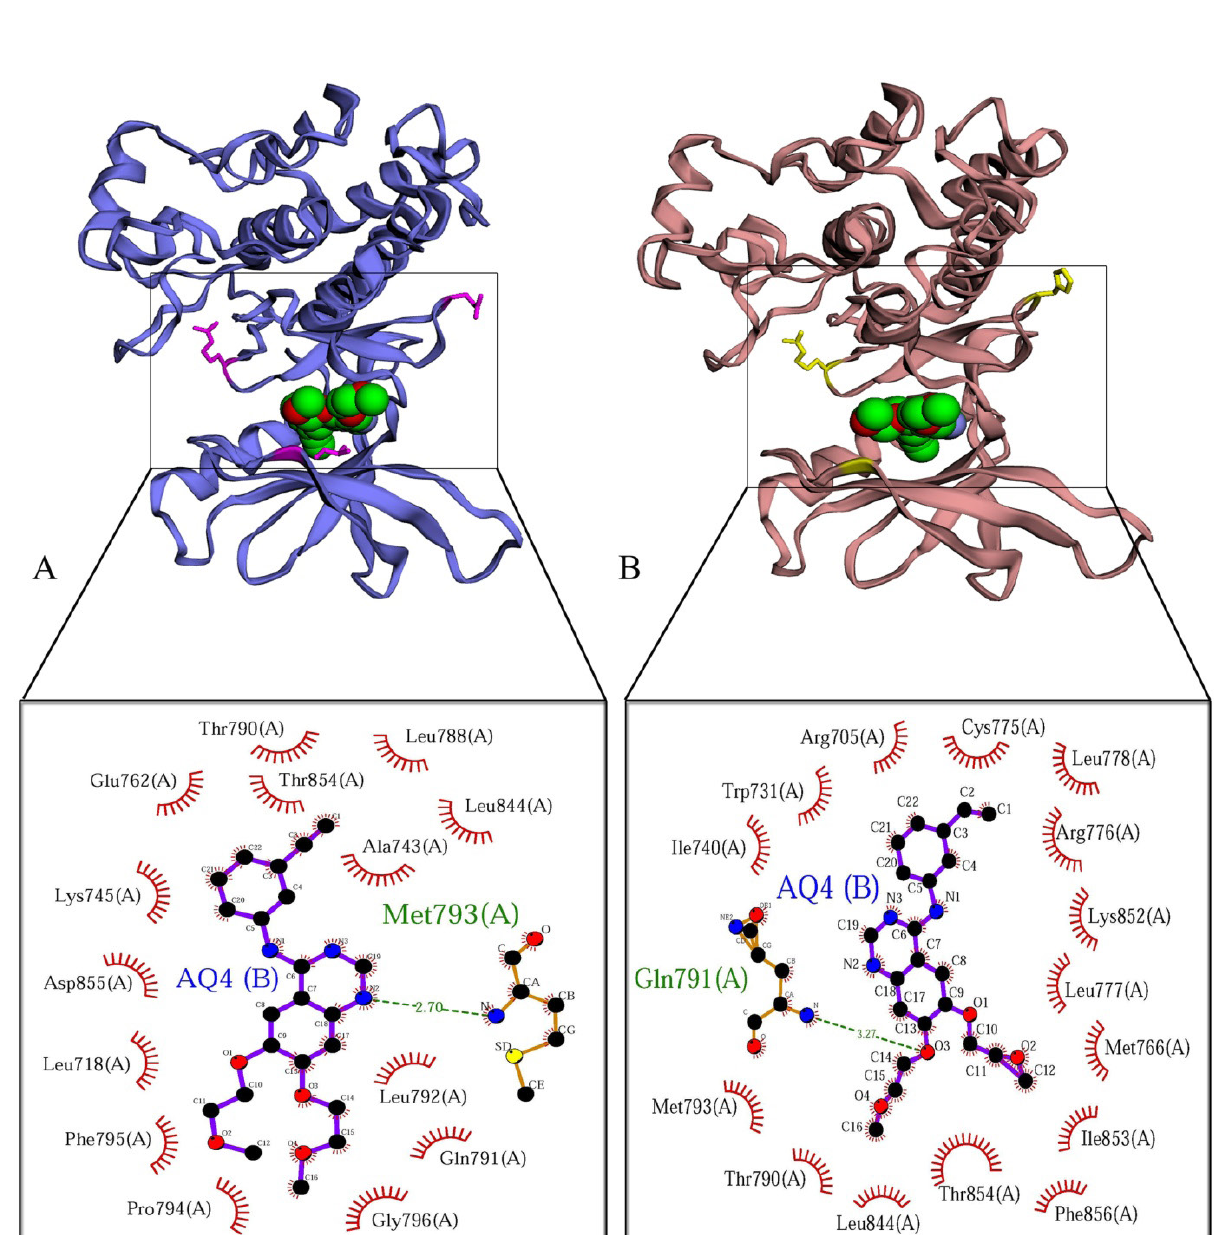
Figure 3: Ligplot analysis of erlotinib binding with the triple mutant and EGFR-L858R. A) EGFR-L858R, and B ) EGFR-AHR form. EGFR residue in H-bond is depicted in orange (chain A ) and AQ4 is (erlotinib) in blue (chain B). The green dashed lines refer to hydrogen bonds. The non-stick residues in red correspond to hydrophobic contacts of EGFR. L718A, and Q849H in EGFR-AHR have changed the hydrophobic interactions of erlotinib compared to